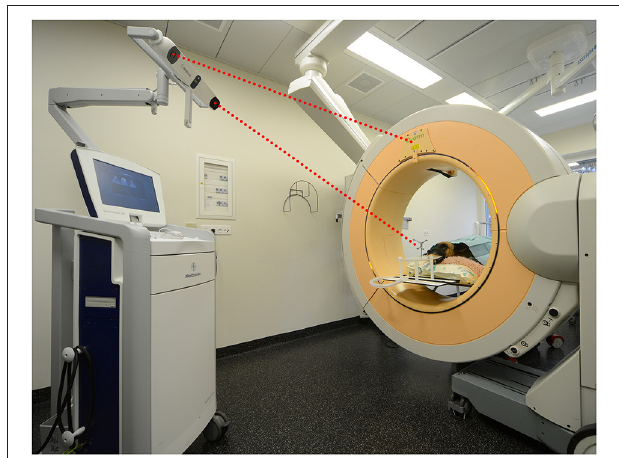
FIGURE 1 | Set up of the mobile cone-beam computed tomography and navigation system in the operating room showing a dog cadaver in sternal recumbency. The head has been secured to the bite plate. For image registration to the patient’s anatomy, a head scan is performed during which the infrared camera must see the reference array and indicator box of the scanner (red dotted